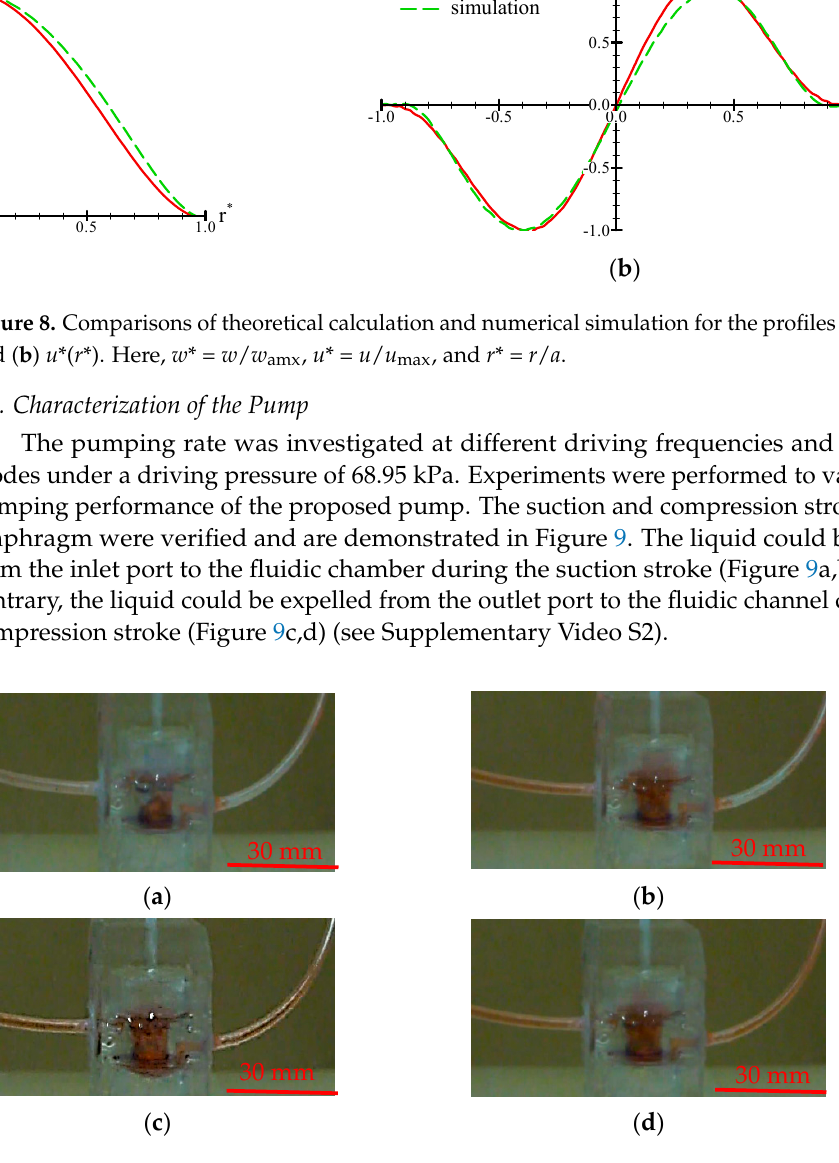
Figure 9. Photograph demonstrating the ( a ) initial-state, ( b ) suction, ( c ) compression and ( d ) expel of the valveless pump.